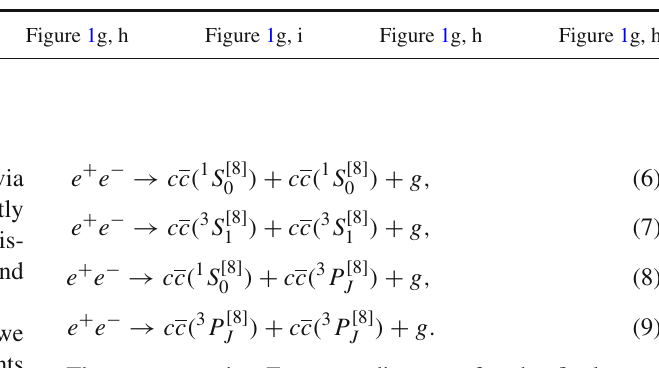
Table 1 Possible Feynman diagrams for each of the final-state-gluon-emission processes. The processes are abbreviated to the numbers of the equations, namely Eqs. (4), (5), (6), (7), (8), (9), in which the processes are presented Process